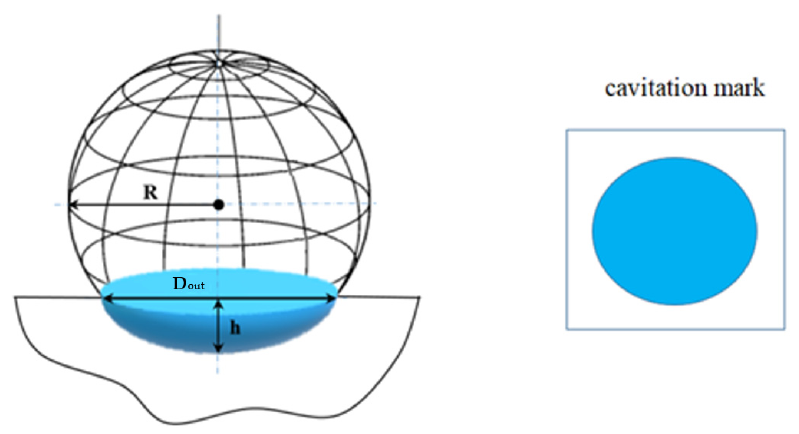
Figure 9. Schematic layout of diameter D out and depth h of cavitation mark in ball segment shape. Figure 8e,f show the obtained kinetic curves of volume removal and corresponding curves of volume removal rate of examined steels 20 GL and 30 L respectively.